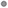
Effect of gap (A-E) and overlap (F-J) training (see Fig. 1 for details of the training regimes).Percentage of express saccades (%ES) is plotted against median saccade latency for ESM (●) and Norm (•) individual participants. For details of the relative timing of different tests in the two training regimes refer to Fig. 1. In plots showing overlap performance during gap (D,E) and overlap training (F-H), the horizontal dashed line is plotted at 30%.